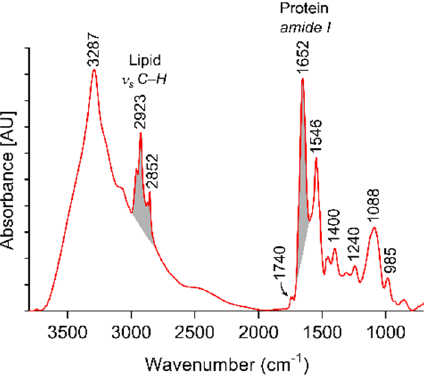
Figure 3. Characterization of platelet-derived EVs by FT-IR. Representative ATR/FT-IR spectra of EVs enriched from platelet concentrate. C-H (2700–3000 cm −1 ) and amide I (1600–1700 cm −1 ) stretch- of EVs enriched from platelet concentrate. C–H (2700–3000 cm − 1 ) and amide I (1600–1700 cm − 1 ) ing regions are highlighted in grey. AU, arbitrary units. stretching regions are highlighted in grey. AU, arbitrary